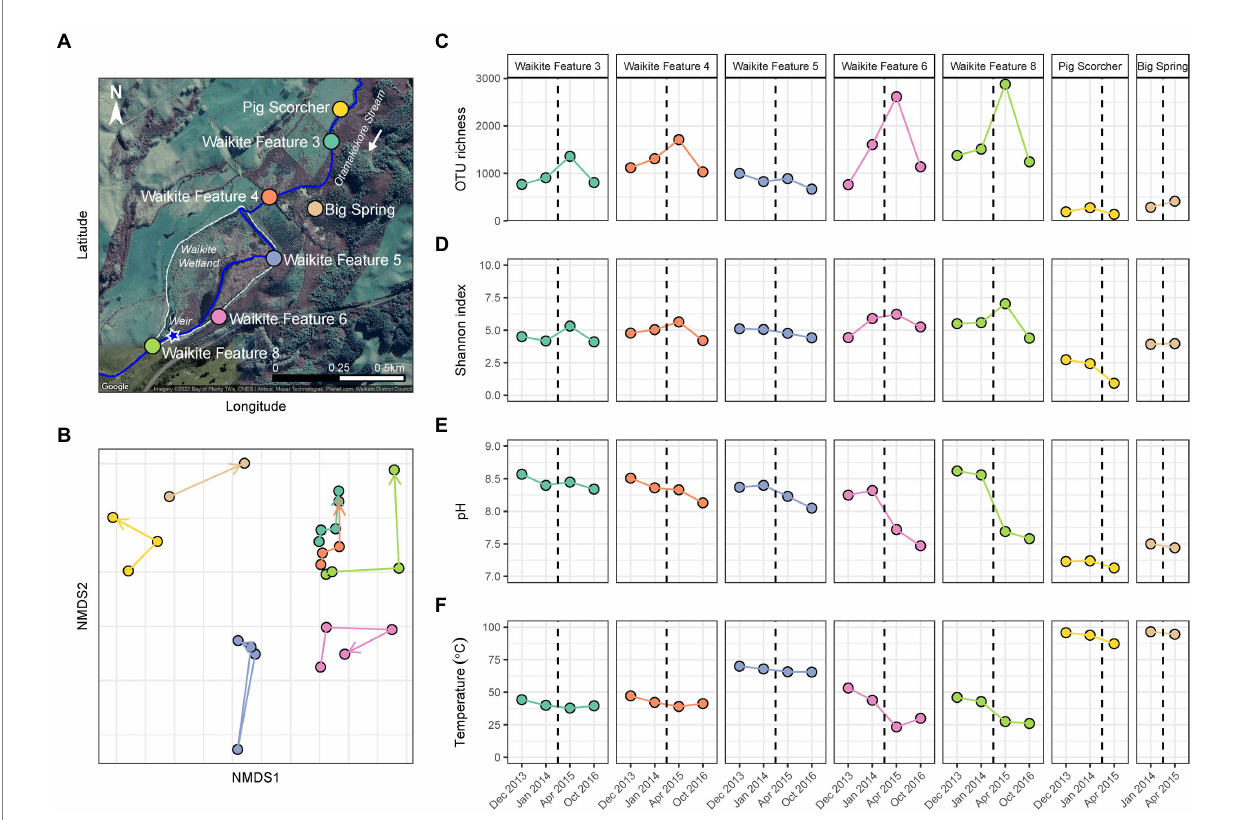
FIGURE 2 Temporal microbial diversity and physicochemistry of the Waikite wetland during restoration. (A) Aerial map of the Waikite geothermal field, including the wetland (dashed white line) and Otamakokore Stream (outlined by the solid blue line). The location of the weir is highlighted by the star, with stream sites and geothermal features sampled distinguished by colour. (B) Non-metric multidimensional scaling (NMDS; n = 25, stress = 0.11) of beta diversity, calculated using Bray-Curtis dissimilarities between 16S rRNA gene sequences of microbial communities in these features. Samples are coloured by feature name, with time indicated by arrows. (C) Variation in alpha diversity of samples measured via OTU richness (i.e., the number of OTUs per community). (D) Alpha diversity was also measured by the Shannon diversity index to indicate evenness of the communities over time. (E) The pH of features at the time of sampling. (F) Temperature variation of all sites during the wetland restoration. The black dashed line indicates the construction of a weir in the southwest corner of the